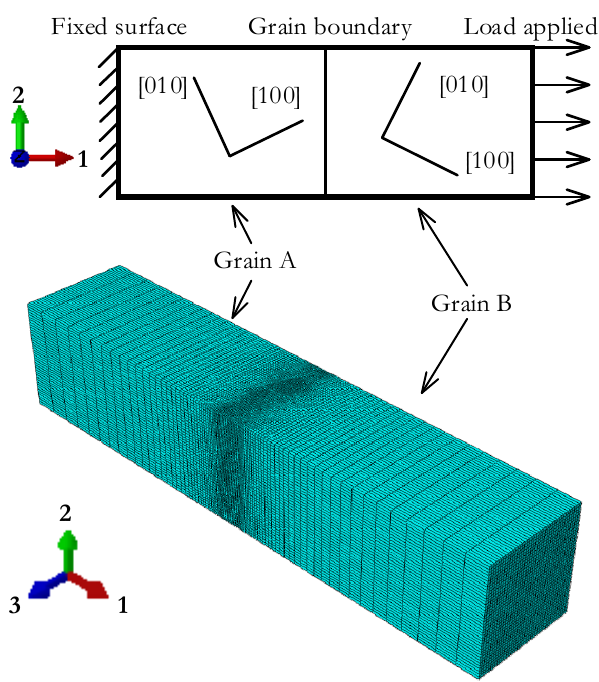
Figure 1. Geometry model of the bicrystal.